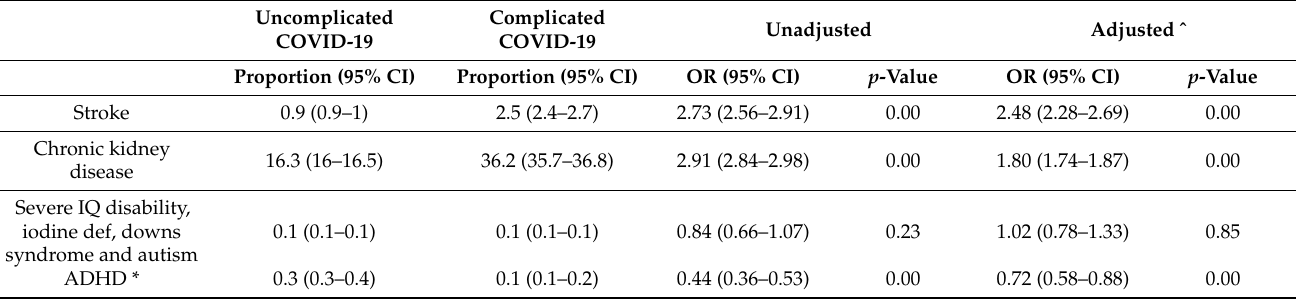
Table 5. Comorbidities which Predict Complicated